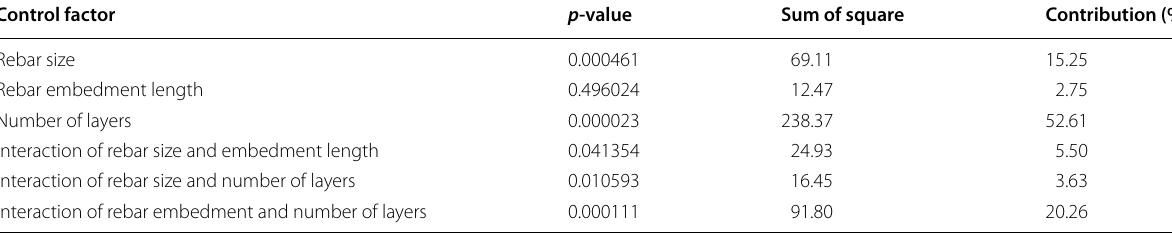
Table 10 ANOVA analysis results for compressive strength.